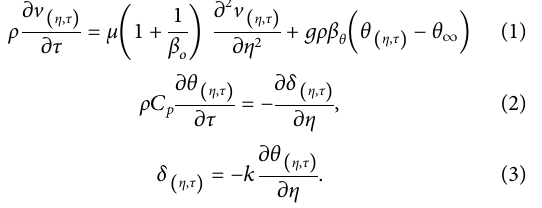
FIGURE 1 Temperature plot for α when β (cid:3) γ (cid:3) 0 . 8 , Pr (cid:3) 11 . 4 , and t (cid:3) 1 .